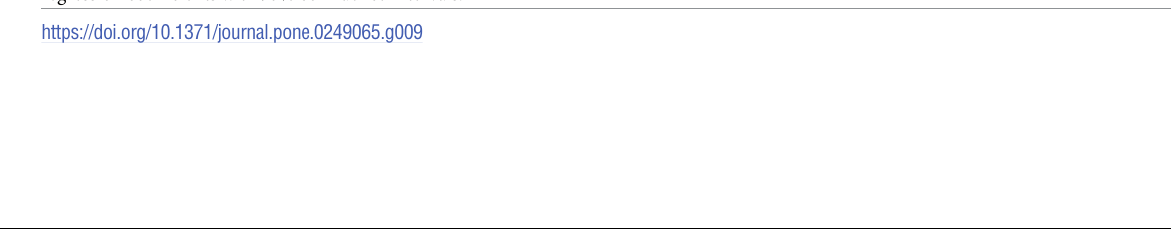
PLOS ONE | https://doi.org/10.1371/journal.pone.0249065 April 22,